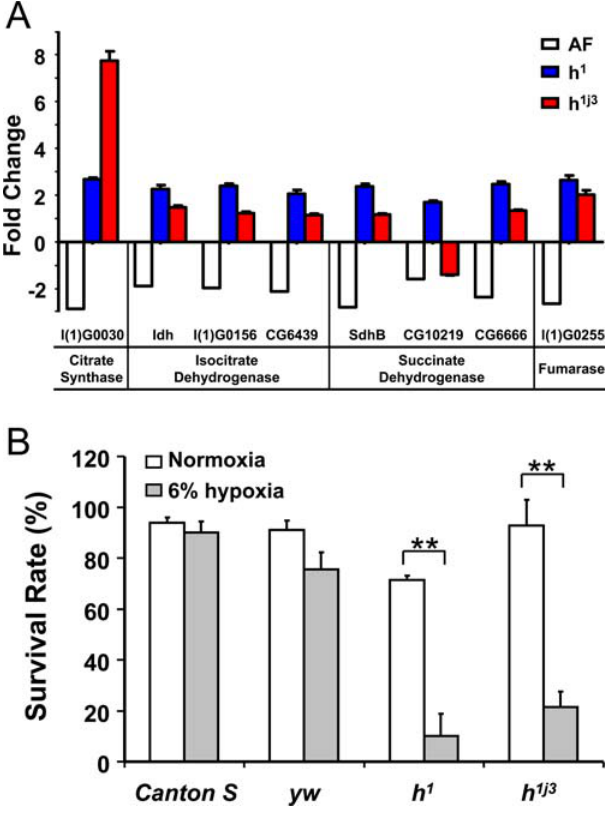
Figure 7. Loss-of-function hairy mutants abolished suppression on the expression of genes encoding TCA cycle enzymes and reduced hypoxia-tolerance in D. melanogaster . A) Abolished suppression of genes encoding TCA cycle enzymes in hairy loss-of- function mutants. The differences in gene expression were measured in yw control and hairy mutants using real-time PCR. Individual genes encoding TCA cycle enzymes had a significantly higher expression level in all hairy mutants than those in control except gene CG10219 . Data were presented as means 6 SD (p , 0.01). Gene description: l(1)G0030: citrate synthase; Idh: isocitrate dehydrogenase; l(1)G0156: isocitrate dehydrogenase; CG6439: isocitrate dehydrogenase; SdhB: succinate dehydrogenase; CG10219: succinate dehydrogenase; CG6666: succinate dehydrogenase; l(1)G0255: fumarase. B) Significant reduction in hypoxia survival in hairy loss-of-function mutants. Embryos from loss-of-function hairy mutants ( h 1 and h 1j3 ) and controls ( Canton-S and yw ) were cultured at normoxic or 6% O 2 hypoxic condition. The ratio of adult flies to pupae was determined as survival rate of each stock. The loss-of- function hairy mutants exhibited a significantly reduced rate of hypoxia survival. Data were presented as means 6 SD (** p , 0.01).